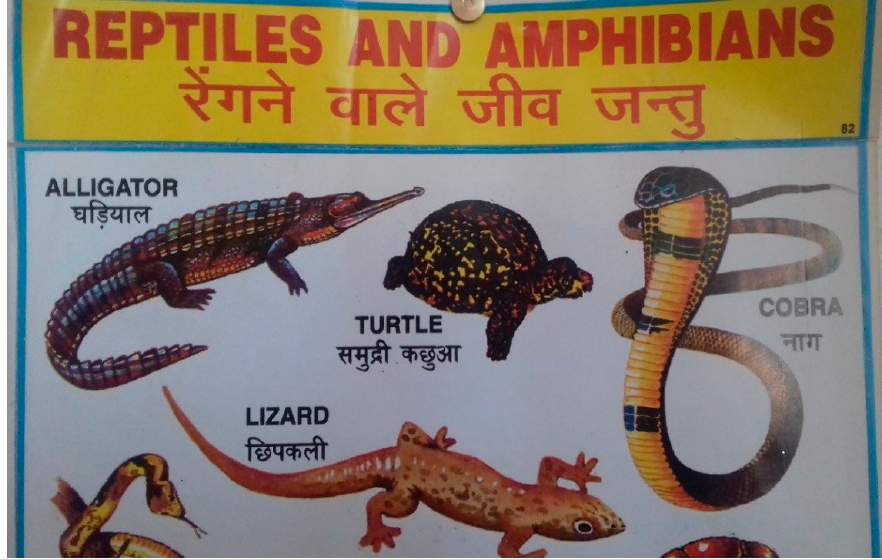
Figure 2. Educational poster, bought by the author in Delhi, autumn 2016. Published by Geeta Enterprises, Delhi.